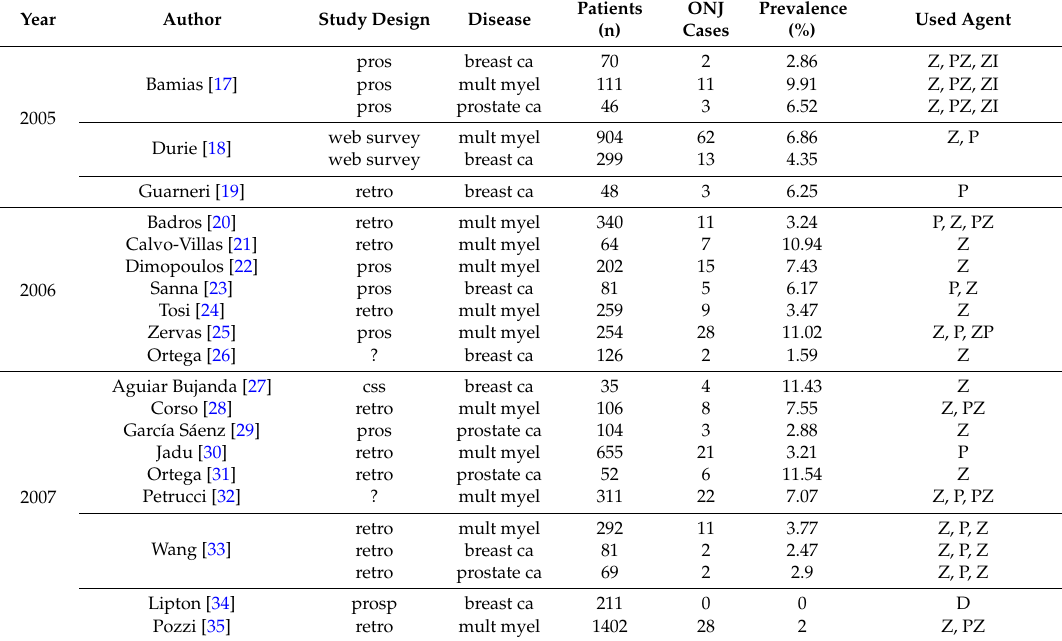
Table 1. Included